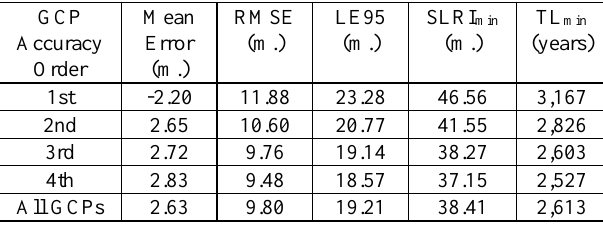
Table 8. Values of parameters related to the vertical uncertainties of the SRTM-30m computed based on the order of GCP accuracy.